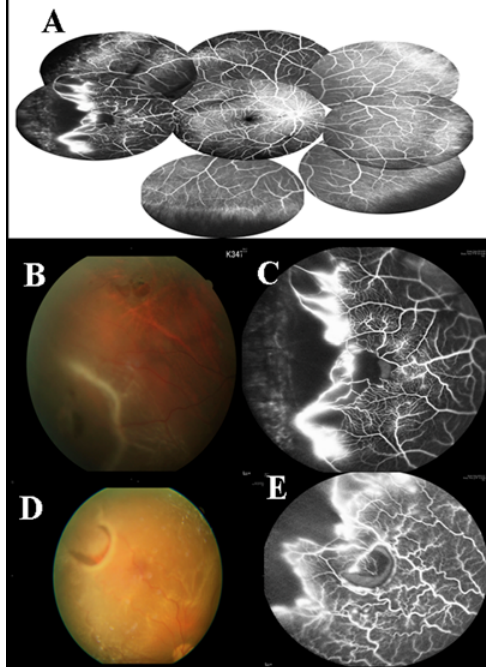
Fig 4. Color fundus and FA photos of group 4 eyes (A) Fluorescein angiography of group 4 vasculature. There is a V-shaped notch at peripheral retina, with peripheral anastomosing vasculature. Non-perfusion areas are noted inside the vascular arch. Wide area of peripheral non-perfusion is noted outside the temporal notch. Marked vascular leakage is noted at temporal anastomosing vessels. (B) Fundus photo of an eye with type 4 vascular pattern showing a tear at the temporal detached retina and 2 breaks associated with lattice degeneration at temporal upper attached retina. (C) Fluorescein angiography of the same eye, showing an avascular notch at temporal aspect and anastomosing vasculature. The tear is within the vascular loop, where the retina is non-perfused. (D) Fundus photo of a horse-shoe tear in an eye with type 4 vasculature. (E) Fluorescein angiography at the same location showing 2 V-shaped notches of the avascular zone. The tear is within a vascular loop, where the retina was partially perfused. Marked leakage was noted at the anastomosing